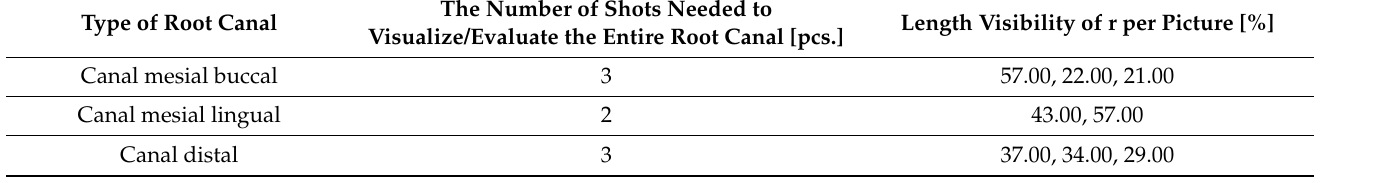
Figure 16. The 3D hologram of tooth 46, subjected to endodontic treatment. Table 6. The minimum number of scans for each root canal is needed to analyze its entire course and the percentage of the length of the canal visible on the scan, in the case of the treatment of tooth 11.